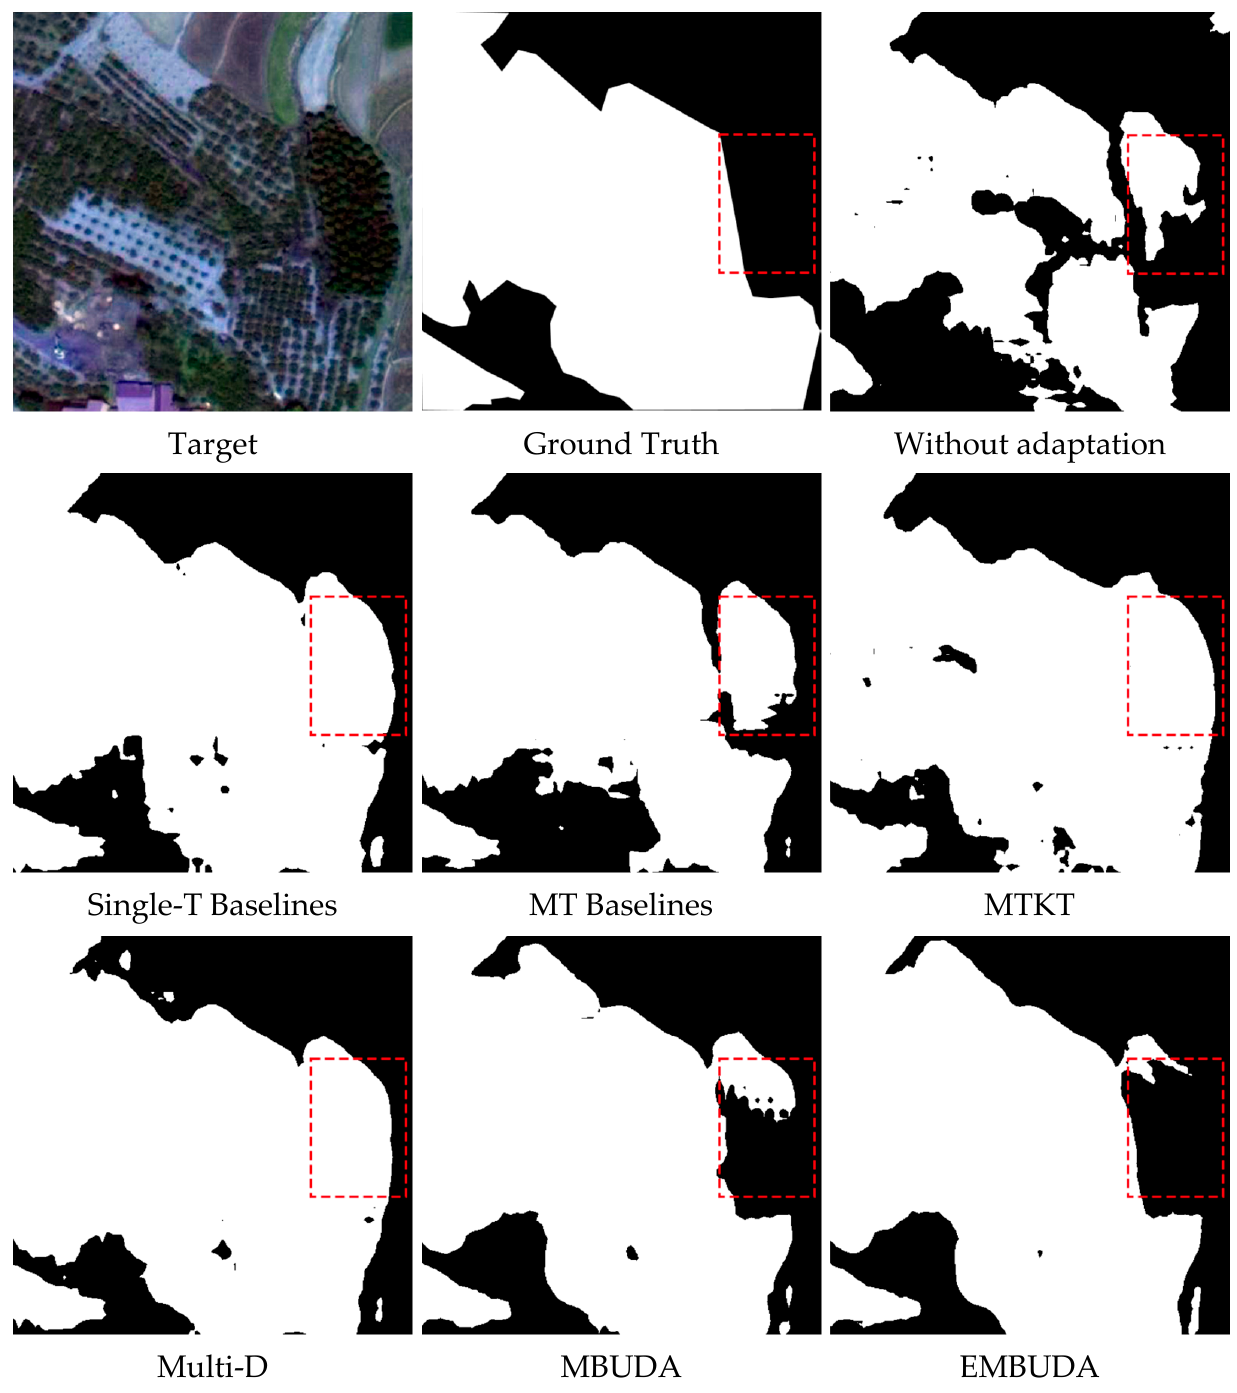
Figure 7. Outputs of orchard area segmentation in Dataset CY when adapting from Dataset ZG to Dataset CY, Dataset XT1, and Dataset XT2.